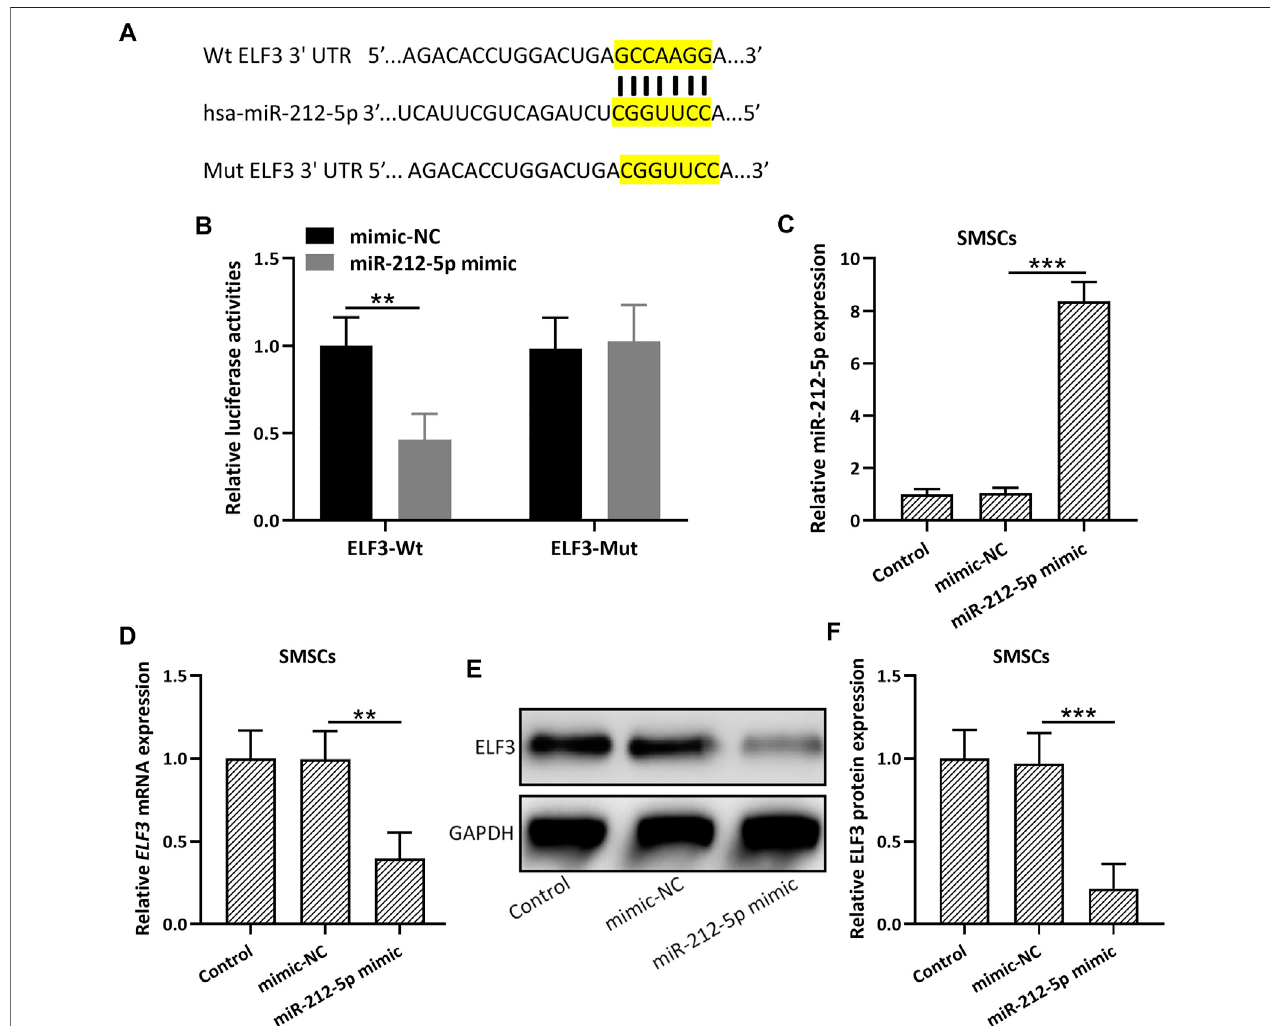
FIGURE 3 | miR-212-5p targeted ELF3 and regulated the expressions of ELF3 in SMSCs. (A) The predicted binding sequences of miR-212-5p with ELF3 mRNA were shown. (B) HEK-293T cells were co-transfected with luciferase reporters containing ELF3 3 ′ -UTR (wide type or mutant) and miR-212-5p mimics or negative control. After 48 h of incubation, the relative luciferase activity was measured. n = 3. Mean ± SD. ** p < 0.01, Two-way ANOVA followed Turkey ’ s multiple comparisons test. (C) qRT-PCR was used to assay the expressions of miR-212-5p in SMSCs and miR-212-5p overexpressed SMSCs. (D – F) , SMSCs were transfected